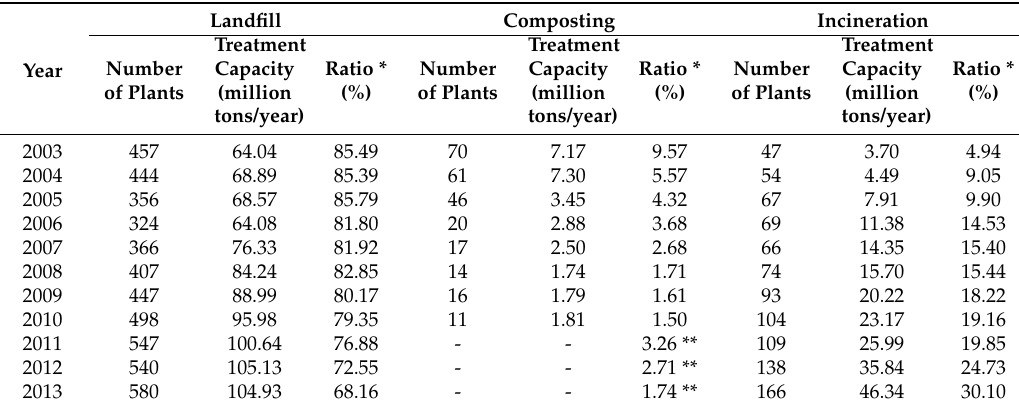
Table 1. The status of MSW disposal in China from 2003 to 2013